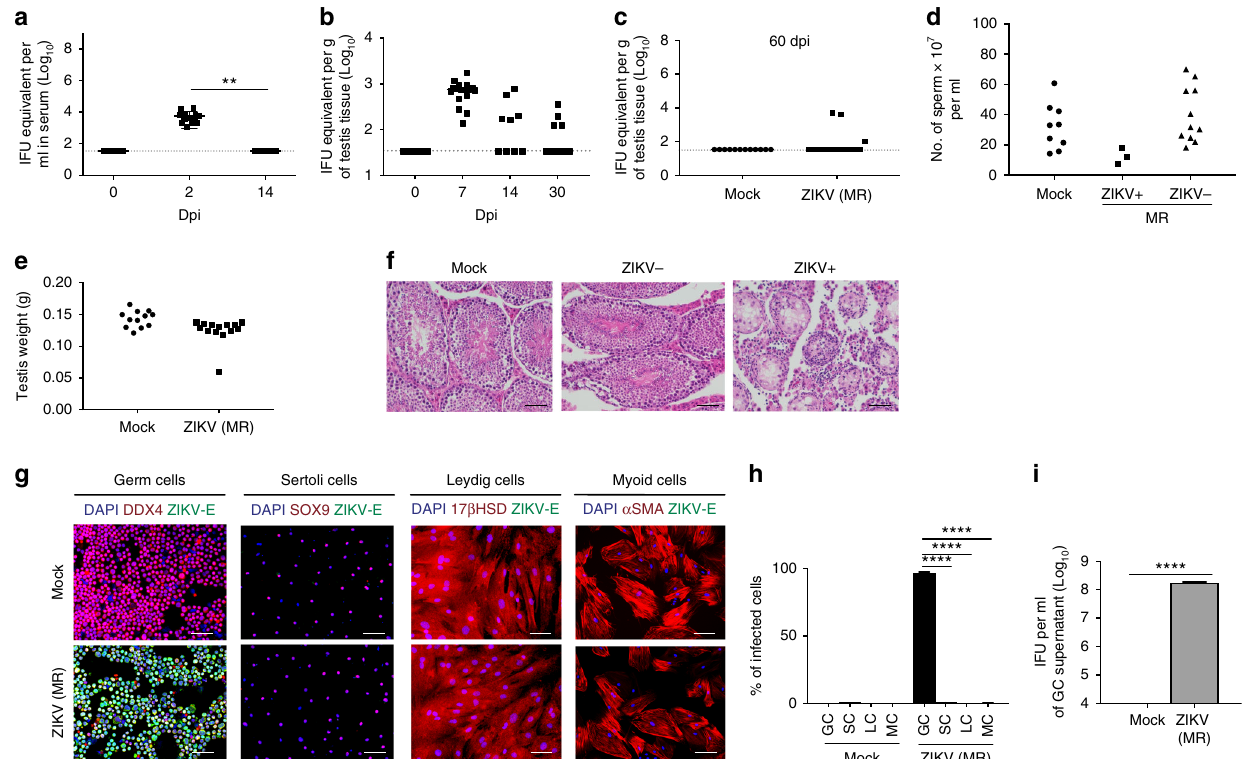
Fig. 1 Murine male GCs exhibit increased susceptibility to ZIKV infection. a – c qRT-PCR analysis of ZIKV vRNA in ZIKV-infected (IFU = 1 × 10 8 ) wild-type CD-1 mice in serum at 0, 2, and 14 dpi ( n = 8, 16, and 7, respectively) ( a ); testis at 0, 7, 14, and 30 dpi ( n = 13, 17, 9, and 13, respectively) ( b ); and testis at 60 dpi ( n = 12 for mock-infected and 14 for ZIKV-infected) ( c ). The dashed line represents the limit of detection. d Sperm count of mock-infected ( n = 10) and ZIKV-infected (IFU = 1 × 10 8 ) with detectable (ZIKV + ; n = 3) and undetectable (ZIKV − ; n = 11) vRNA in the testis of wild-type CD-1 mice at 60 dpi. e Testis weight in mock-infected and ZIKV-infected (IFU = 1 × 10 8 ) wild-type CD-1 mice at 60 dpi ( n = 12 for mock infected and 14 for ZIKV infected). f Hematoxylin and eosin staining of mock, ZIKV − , and ZIKV + testis at 60 dpi. g , h Mock-infected and ZIKV-infected (MOI = 0.1 PFU per cell) GCs (DDX4), SCs (SOX9), LCs (17 β -HSD), and MCs ( α -SMA) immunostaining ( g ) and quanti fi cation ( n = 5, 3, 5, and 8, respectively, for each group) ( h ). i Quanti fi cation of infectious ZIKV in supernatant of mock-infected and ZIKV-infected (MOI = 0.1 PFU per cell) GCs at 72 hpi by intracellular fl ow cytometry-based Vero assay ( n = 3). Data are presented as mean ± s.e.m. and analyzed by two-sided t test and one-way ANOVA, ** p ≤ 0.01, or **** p ≤ 0.0001. Scale bar, 50 μ m. ZIKV strain is MR